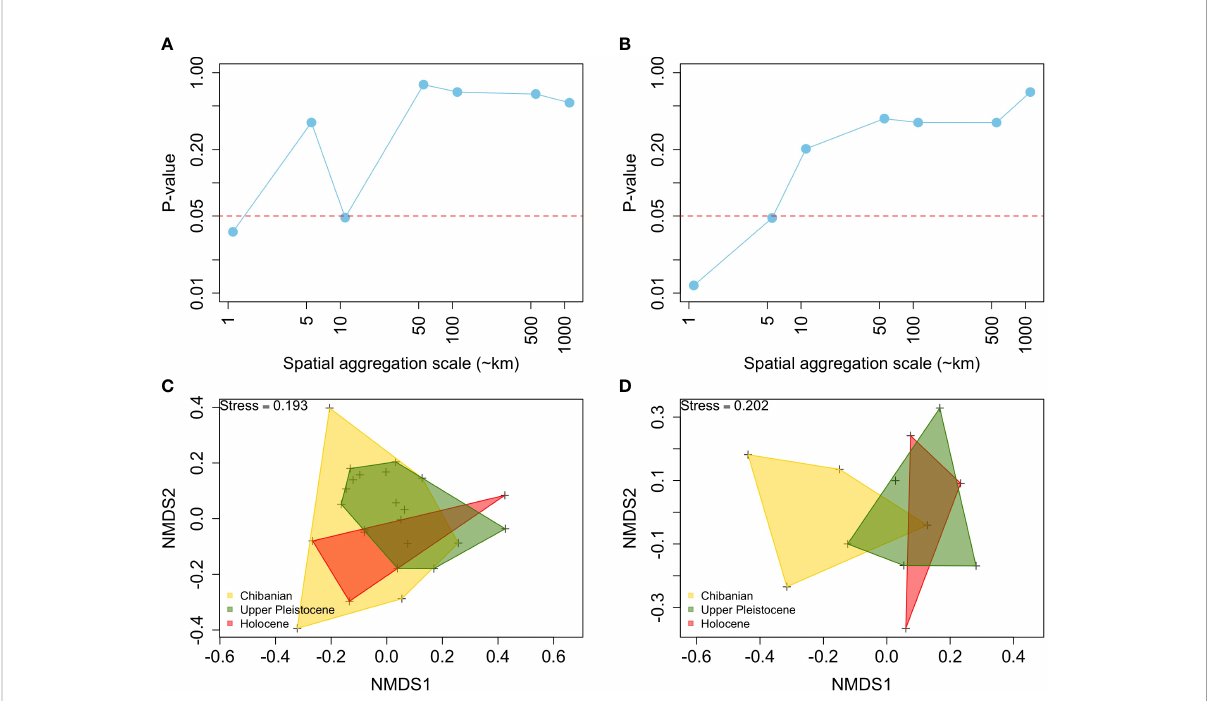
FIGURE 3 Long-term stability in the species composition of fossil assemblages, showing p-values of the permutational analysis of variance among time intervals based on the Jaccard (A) and Chao indices (B) across spatial scales of aggregation. Also shown are non-metric scaling 2-D representations of the species composition, using as an example the 10 km aggregation scale, for the Jaccard (C) and Chao indices (D)